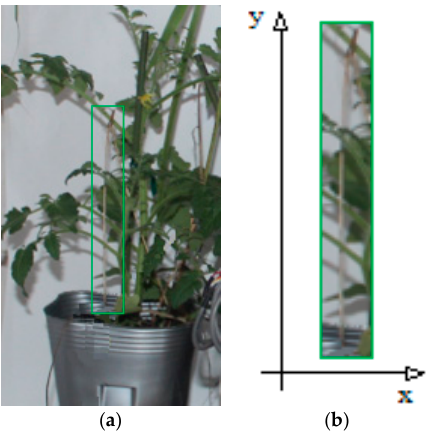
Figure 9. Determination of the diameter of the stem of the weed. ( a ) Identification of the weed; ( b ) calculation of the length of the weed.